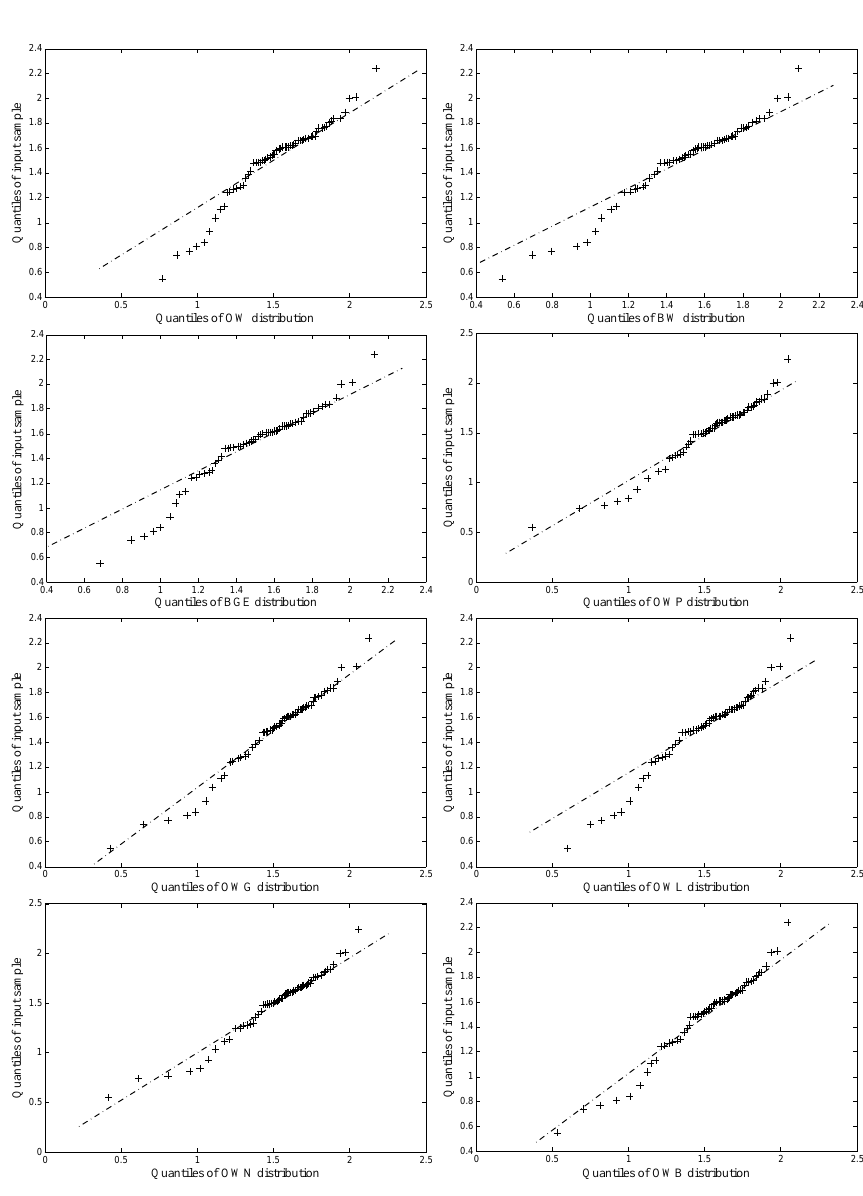
Figure 5 – Quantile-quantile plots for the fitted distributions for the first data